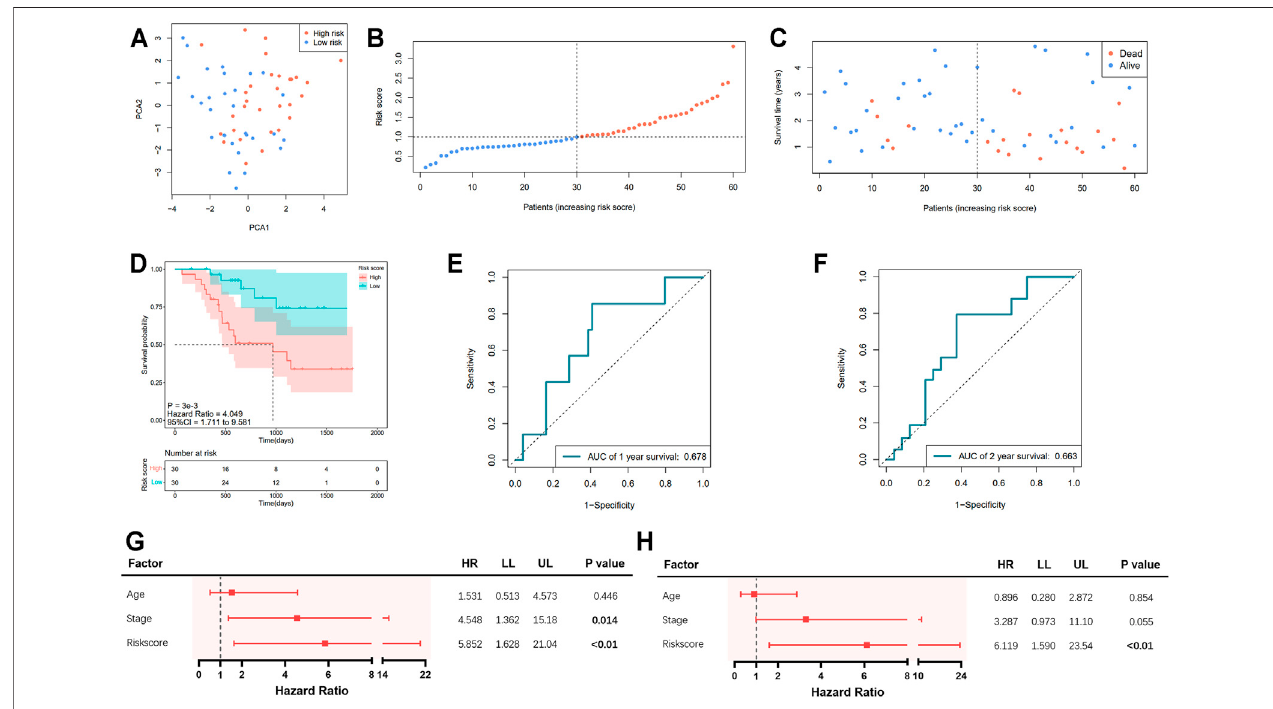
FIGURE 4 | Validation of the pyroptosis-related fi ve-gene signature in the GSE13898 cohort. (A) Principal component analysis (PCA) of the risk groups. (B) Distribution of patients according to risk scores. (C) Survival time and status of patients. (D) Kaplan – Meier curves for the survival of patients in the low- and high-risk groups. (E, F) Receiver operating characteristic (ROC) curve for 1-, 2-, and 5-year survival of patients. (G) Univariate Cox analysis. (H) Multivariate Cox